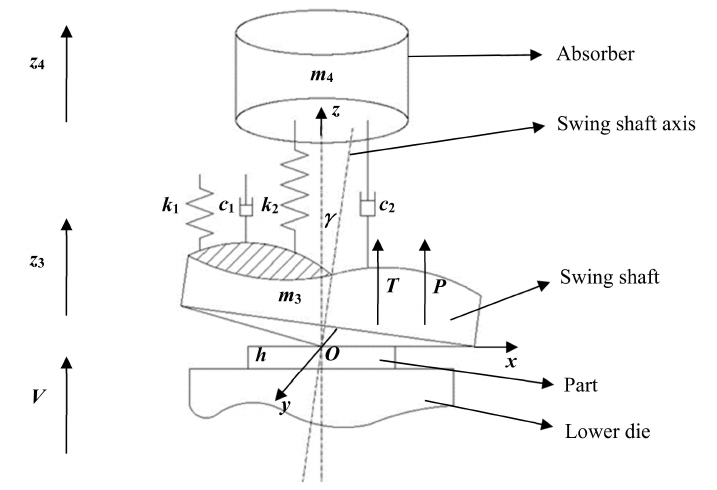
Figure 22. Vertical dynamic model of the swing